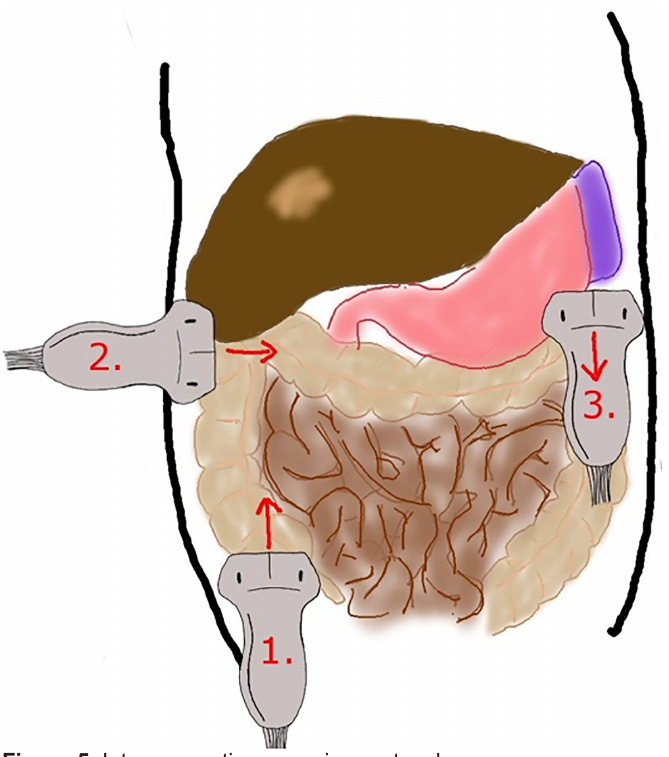
Figure 5. Intussusception scanning protocol. Initially published online on ALIEMU.com and permission to use given by author